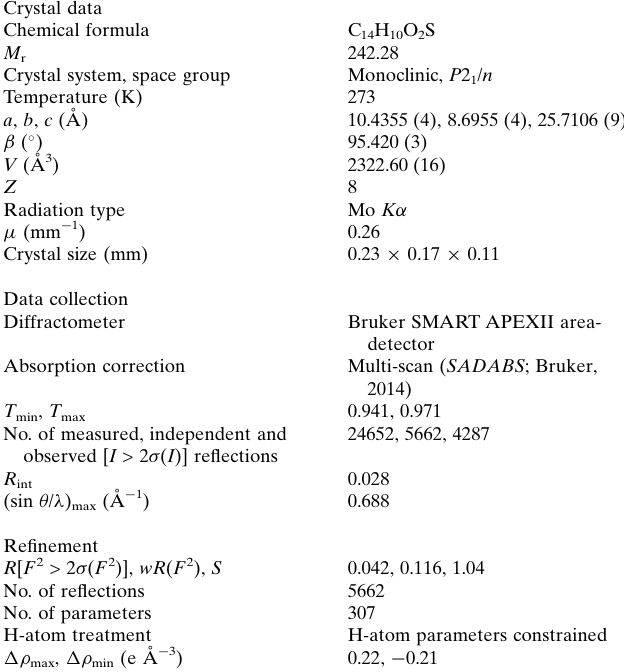
Table 2 Experimental details.